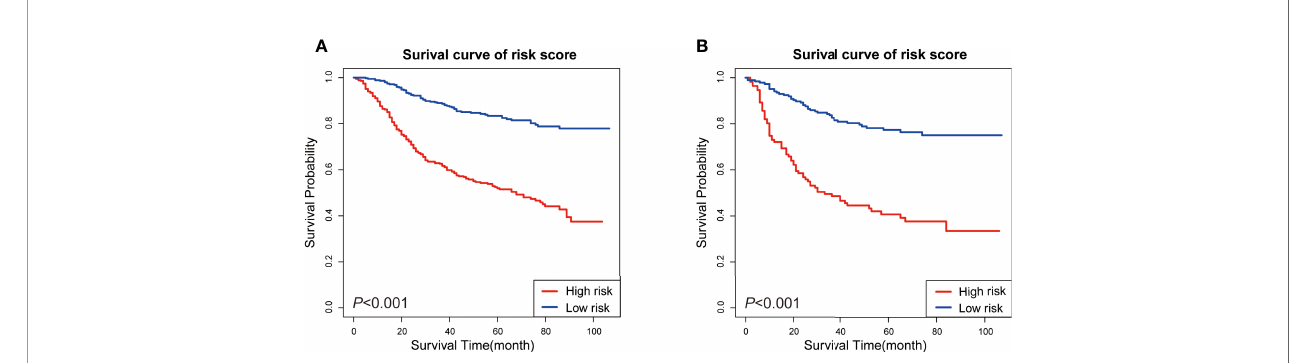
FIGURE 6 | KM survival analysis of patients in different risk subgroups. (A) KM survival analysis in the training set, (B) KM survival analysis in the